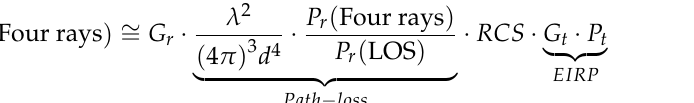
Figure 5. Multi-ray experiment with round plate. In the first experiment, we demonstrated the reflection from a round plate. The plate diameter was 235 mm, and it was located close to the table, as shown in Figure 5 . In this scenario, the plate formed a right angle with the table. This served as a specific reflector, causing only three possible ray paths between the transmitter and receiver. The experiment was carried out repeatedly, while the target moved on the radial axis back and forth between distances of 400–1500 mm . The received power was recorded, and graphs were drawn as a function of the distance. Figure 6 shows the normalized received signal strength vs. the distance to the target. A comparison between analytical calculations and experimental results was performed via the locations of peaks and dips of the signal strength measured along the distance, corresponding to constructive and destructive interferences. It can be seen that the power peaks and dips follow the two-ray model, where path 4 in Equation (4) is omitted.